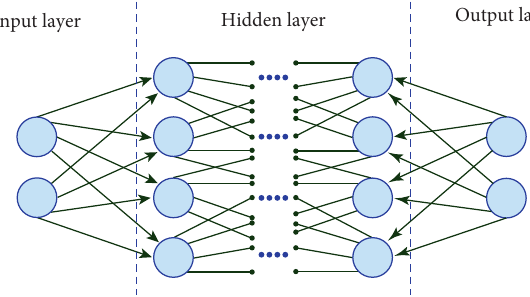
Figure 9: Neural network